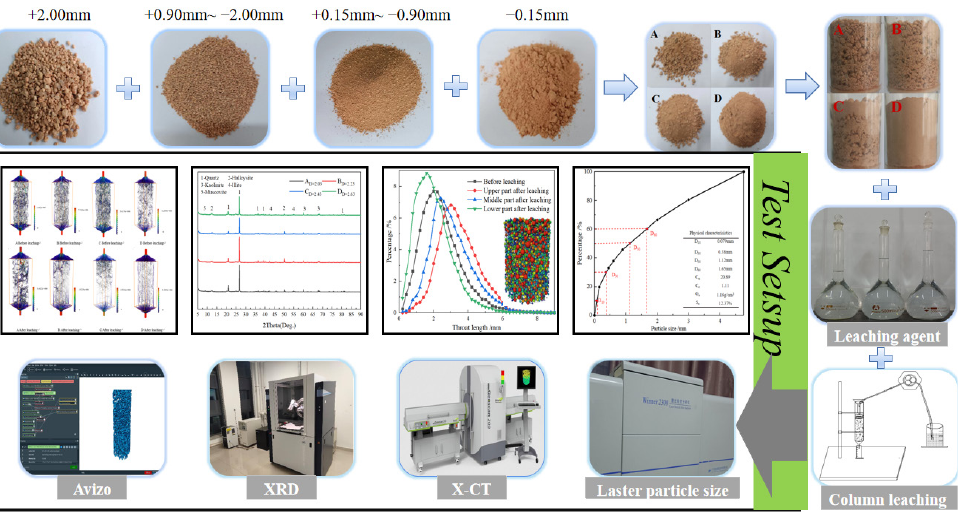
Figure 3. Preparation of experimental samples, including experimental equipment and test outcomes.